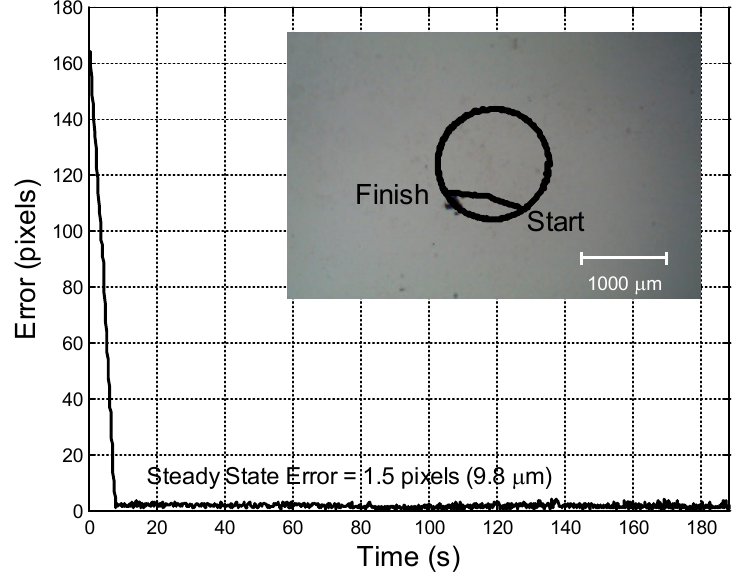
Figure 9. Normalized control effort for the experiment given in Figure 8. The effort is normalized such that a 1 represents the maximum 50% duty cycle applied to a